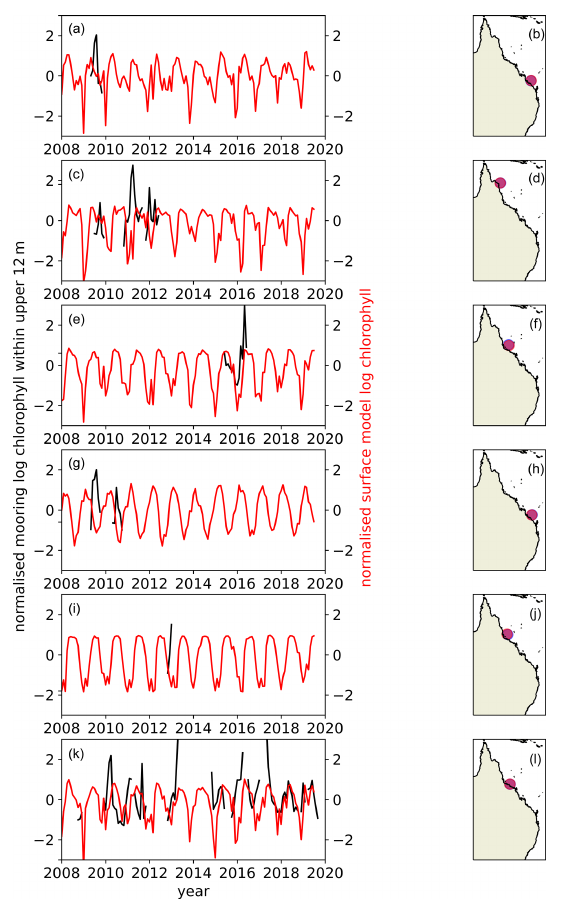
Figure 19. Comparison of model chlorophyll- a time series (red) with chlorophyll- a fluorescence measurements (black) made on six moored buoys situated down the GBR as part of the IMOS FAIMMS. Both datasets have been averaged monthly and logged, had the time series mean removed and have been normalised by their standard deviation. Surface level data were not available for all sites, so data represent an average over the top 12m of the water column to improve spatial data